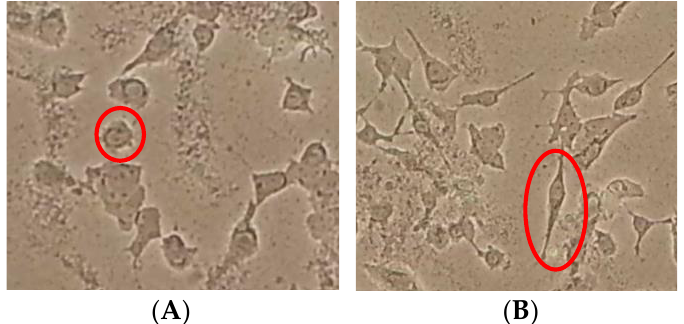
Figure 3. Morphology of SK-N-S H cells treated with Aβ 42 . ( A ) The cells treated with 25 μM Aβ 42 for 24 h showed a roundup of cell bodies and loss of neuritis. ( B ) The cells treated with Aβ 42 and com- pound 5 resulted in healthy cell bodies and neuritis.